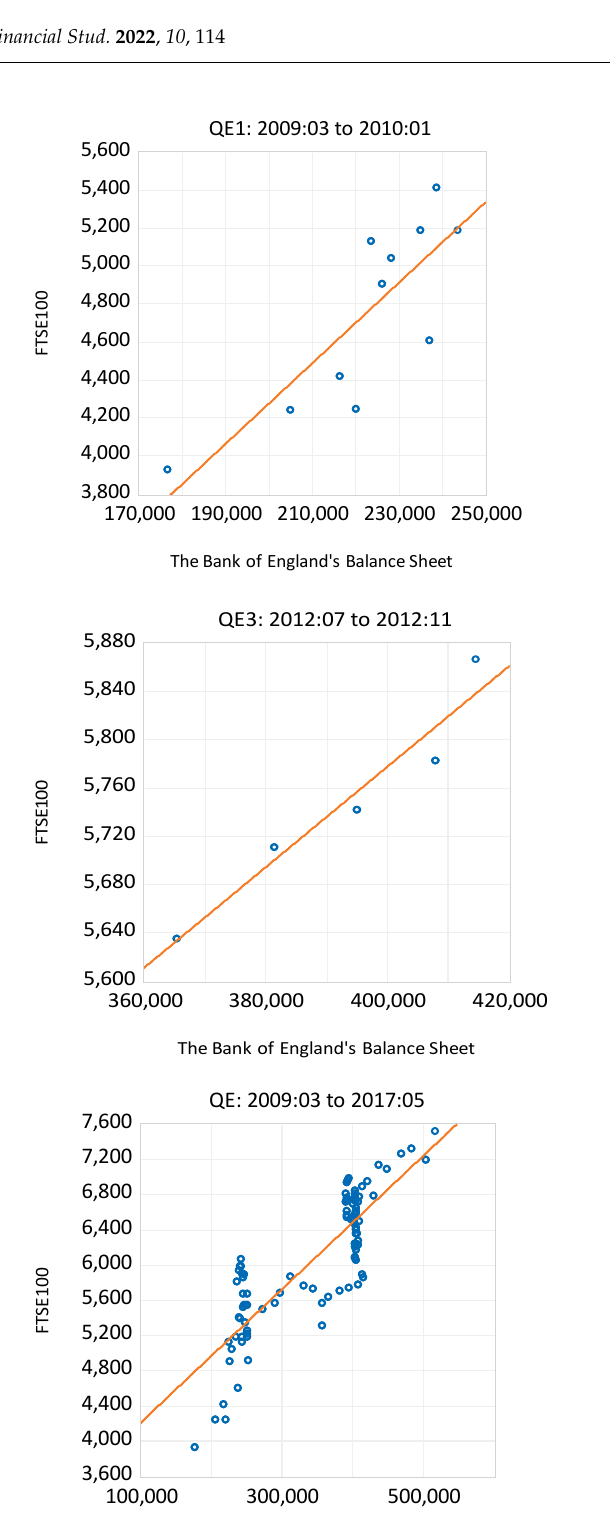
Figure 2. Scatter plot of the FTSE100 against the Bank of England’s balance sheet (in millions).